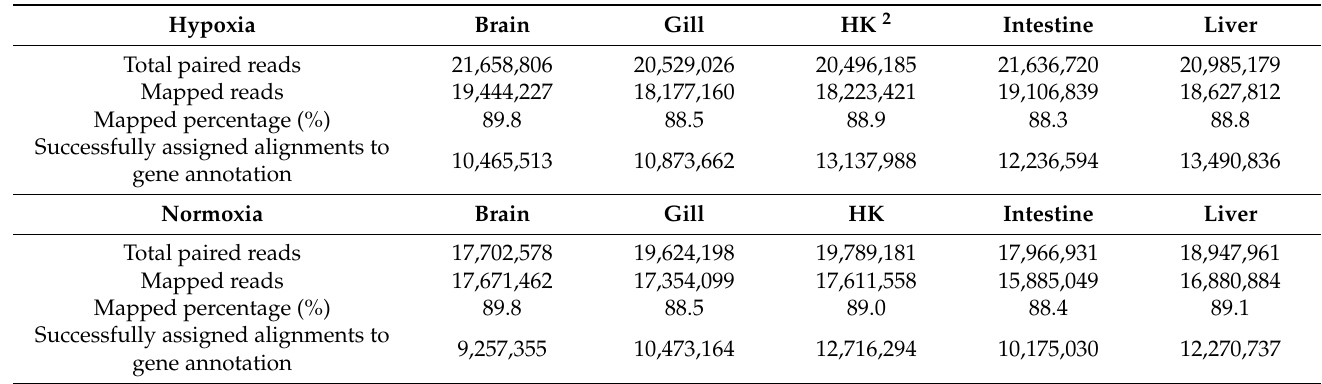
Table 1. Summary of RNA sequencing and alignment to Chinese common carp 1 .